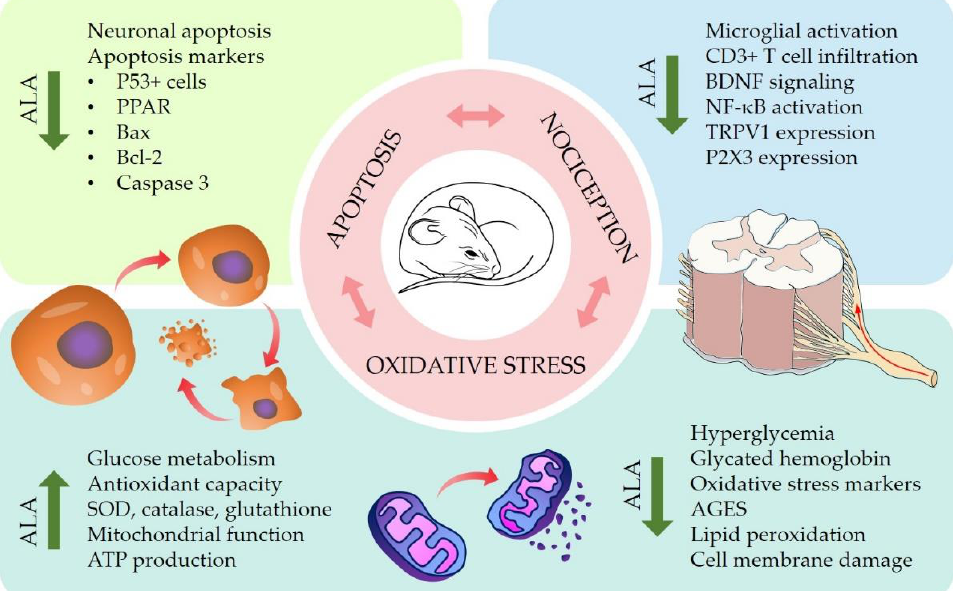
Figure 2. Effects of alpha-lipoic acid (ALA) on preclinical models of neuropathic pain (NP). In vitro and in vivo studies have provided insights in the mechanisms by which ALA reduces neuronal apoptosis, oxidative stress, and nociceptive signaling in several models of NP. Graphical representations of mouse and spinal cord are adapted with permission from SciDraw.io [95,96] .